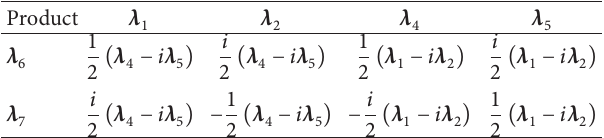
Table 7: Multiplication table of Gell-Mann matrices { 𝜆 6 , 𝜆 7 }{ 𝜆 1 , 𝜆 2 , , 𝜆 } (left times top). 𝜆 4 5